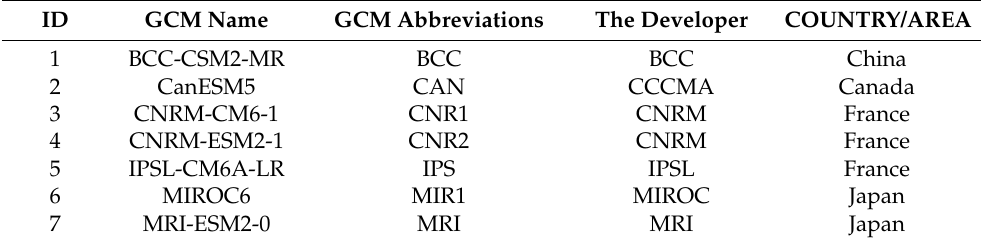
Table 1. Information of the 7 global climate models (GCMs) applied in the study.